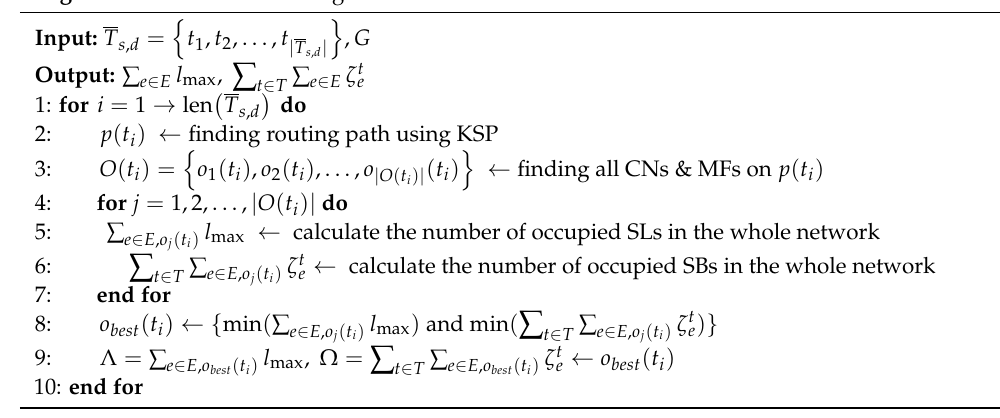
Algorithm 2 SLs and SBs Assignment